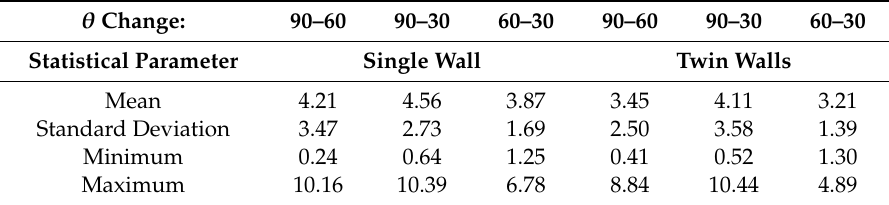
Figure 8. Variation of K t with θ for d / L p = 0.0844 and different porosities and wall configurations. On the left, H is / d = 0.2493 ( a , b , and c ) and on the right H is / d = 0.1284 ( d , e , and f ). Table 4. Simple statistics of the percentage of increase in K t as a function of wall slope angle and number of walls.